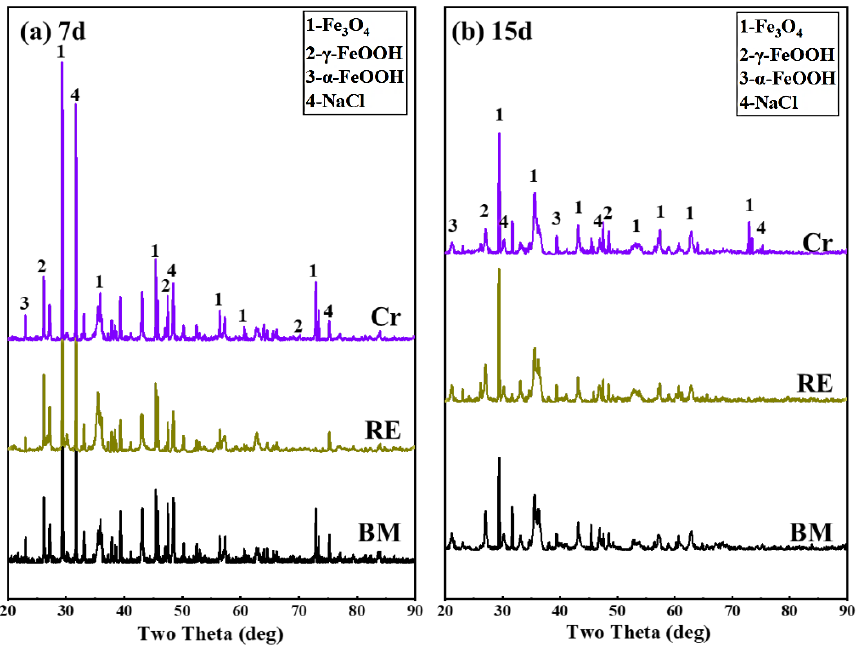
Figure 13. Phase compositions of the corrosion products formed on the three steel rebars after corrosion tests characterized by XRD: ( a ) 7 days and ( b ) 15 days.